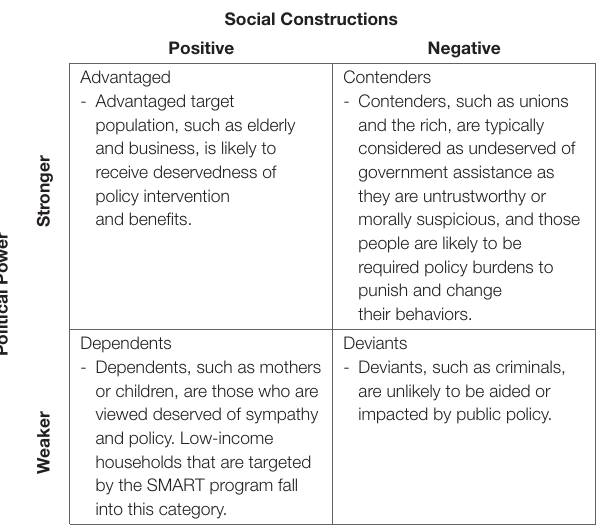
o P ca l t i o li P